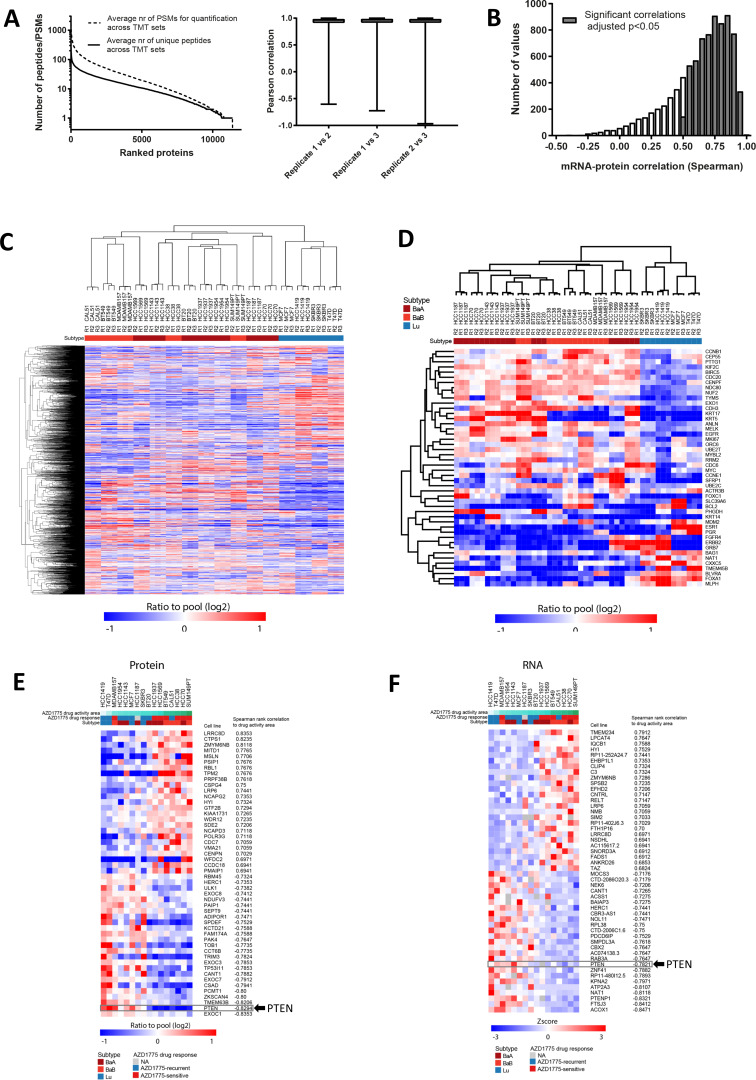
PTEN predicts sensitivity and response to AZD1775 monotherapy.(A) Unique peptides and peptide spectrum matches (PSMs) for the mass spectrometry-based proteomics data of the 16 cell lines in triplicate. Proteins are ranked according to average number of unique peptides used for protein identification and average number of peptide spectrum matches (PSMs) used for quantification across the triplicates for the 16 cell lines (6 TMT10plex sets). Cell lines are the same as used in the drug screen (left). Quantitate accuracy between replicates in the MS proteomics data set with 16 cell lines. Box plots show the correlation between replicates for each gene (right). (B) Correlation between protein and mRNA for the 16 cell lines. (C) Clustering of all proteins with quantification across all three replicates in the MS proteomics data set. Spearman, average linkage. (D) Clustering based on protein levels of the 16 cell lines based on the PAM50 genes. Spearman, average linkage. (E) Proteins associated with AZD1775 drug response. Top 25 most correlated and anti-correlated proteins and RNAs to AZD1775 drug activity area (as in Figure 2A). (F) RNA expression associated with AZD1775 drug response. Top 25 most correlated and anti-correlated proteins and RNAs to AZD1775 drug activity area (as in Figure 2A).